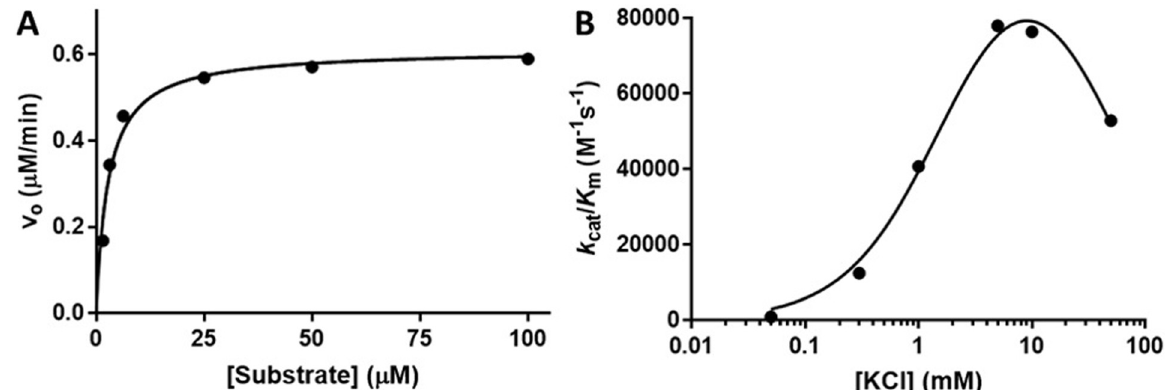
Fig 3. KCl regulates HDAC3:NCOR2 catalytic activity. HDAC3:NCOR2 activity and its dependency on KCl concentration was determined by constructing Michaelis-Menten plots (a representative plot is shown in panel A at 5mM [KCl]) at varying concentrations of KCl (0.05 mM-50 mM), Fluor de Lys SIRT1 substrate (1.56 μ M-100 μ M) and 0.1 μ M HDAC3:NCOR2 in 25 mM Tris pH 8.0 with 500 μ M EDTA. Initial velocities were determined from time course data based on changes in fluorescence. Catalytic parameters were determined and are summarized in Table 1. Eq 1 was used to fit the bell-shaped dependency of HDAC3:NCOR2 activity with varying [KCl] (panel B) yielding K 1/2,act and K 1/2,inhib values.